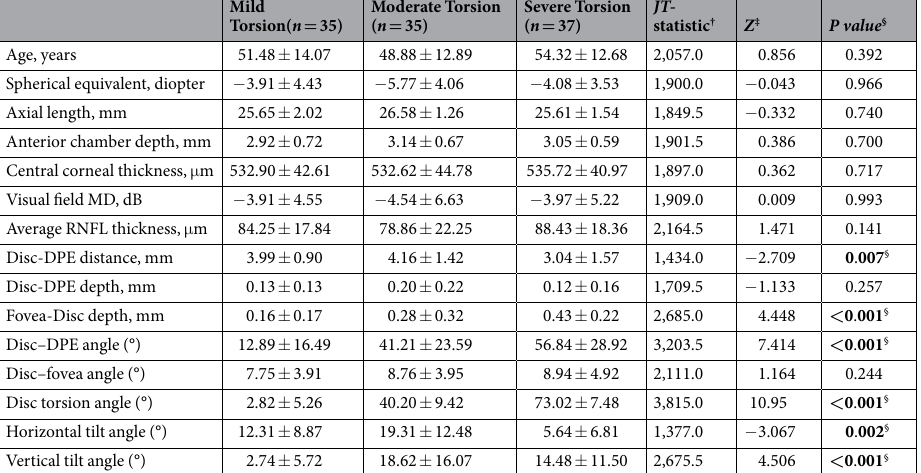
Table 1. Baseline characteristics and the posterior pole analysis of the 3 groups * . MD: mean deviation, RNFL: retinal nerve fiber layer, DPE: deepest point of the eyeball. * Data are presented as mean ± standard deviation unless otherwise indicated. † Test statistic value of the Jonkheere-Terpestra test. ‡ Standardized Test Statistic of the Jonkheere-Terpestra test. § Statistically significant values ( P < 0.05) are shown in